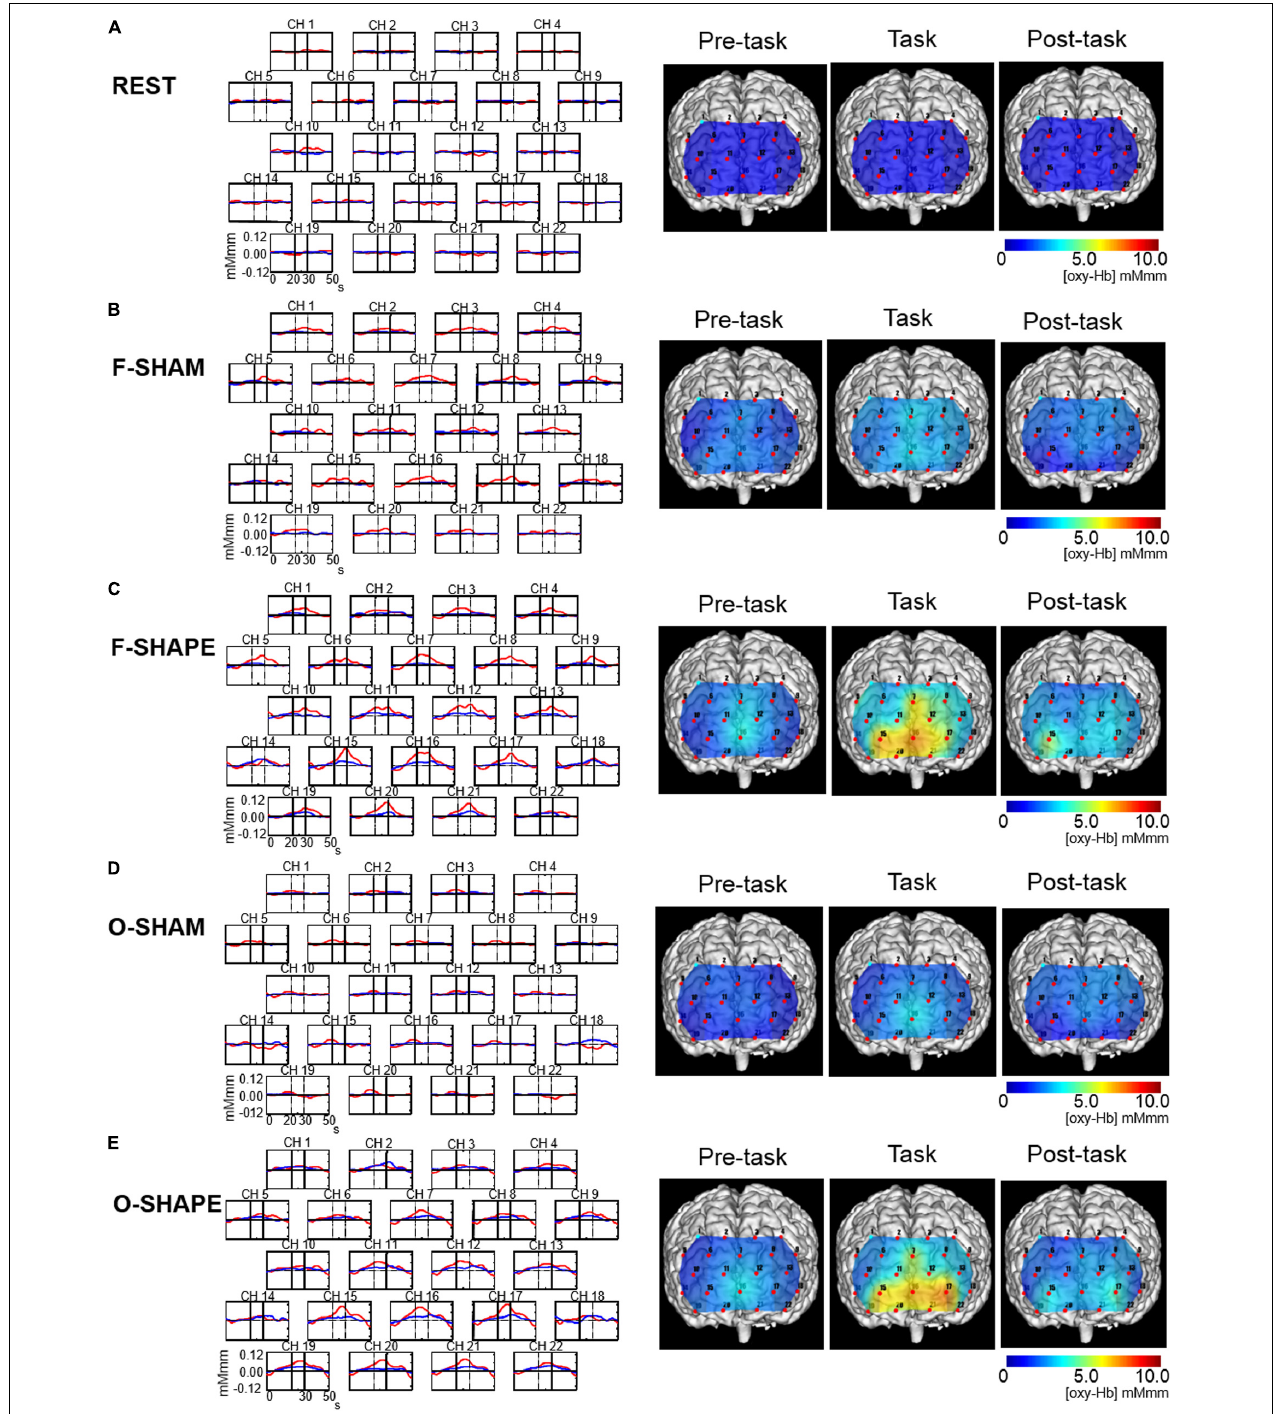
FIGURE 2 | Grand average waveforms and topographical maps of the prefrontal functional near-infrared spectroscopy (fNIRS) activities. Shown on the left are the grand averages in the six subjects’ waveforms of oxygenated hemoglobin concentration ([oxy-Hb], red line ) and deoxygenated hemoglobin concentration ([deoxy-Hb], blue line ) for each of the 22 measurement channels during the REST, SHAM, and SHAPE blocks of finger and oral shape discriminations. The x -axis indicates time (in seconds) and the y -axis indicates hemodynamic changes in [oxy-Hb]. Vertical lines at 20 and 30 s indicate the onset and offset of the 10-s task period. Shown on the right are the topographical maps of the changes in [oxy-Hb] during the 10-s period preceding the task, the 10-s task period, and the 10-s period following the task period during the REST, SHAM, and SHAPE blocks of finger and oral manipulations. Changes in [oxy-Hb] during the task periods were not clearly demonstrated during the REST and SHAM blocks (A,B,D) , whereas it was clearly increased during the F-SHAPE and O-SHAPE (C,E) .